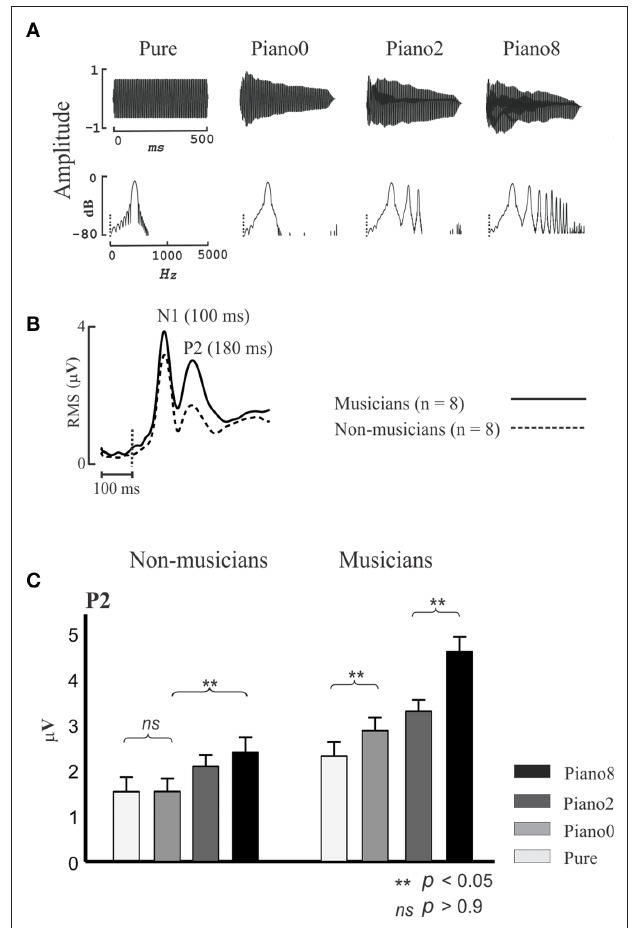
FiGurE 2 | P2 indexes spectral complexity and is enhanced in musicians. (A) Temporal (top) and spectral (bottom) profiles of Pure, Piano 0, Piano 2, and Piano 8 tones. The pure tone had only the fundamental frequency (f notation), and Piano 0, Piano 2, and Piano 8 have the f and f + first 8 harmonics, respectively. Piano 0, Piano 2, and Piano 8 have the 0 temporal envelope of the Piano C4 notation. (B) Root mean square (RMS) of auditory-evoked potential (AEP) waveforms for all channels (32; averaging across all stimuli) for musicians and non-musicians. (C) P2 RMS peak values for musicians and non-musicians for all stimuli. Based on data from Shahin et al. (2005). The error bars depict